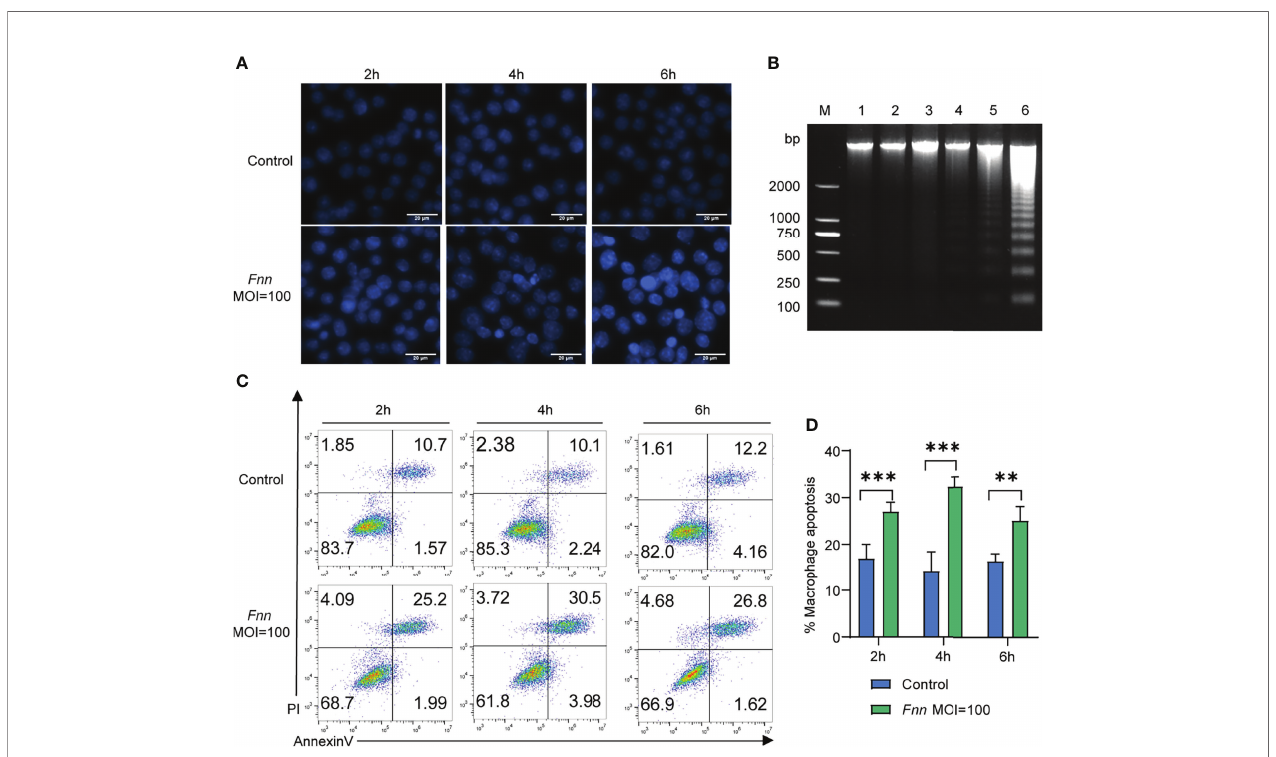
FIGURE 2 | Apoptosis of macrophages cells induced by F. necrophorum (MOI=100). (A) Hoechst 33258 staining fl uorescent display. (B) Effect of the F. necrophorum on chromosomal DNA fragmentation (Lane M: DNA marker 2000; Lane 1, 3, and 5: macrophages were cultured for 2, 4, and 6 h without F. necrophorum ; Lane 2, 4, and 6: macrophages cultured for 2, 4 and 6 h incubated with F. necrophorum ). (C) . Flow cytometry analysis of macrophages apoptosis with F. necrophorum stimulation (MOIs of 0 and 100) at 2, 4, and 6 h. (D) . Statistical analysis of macrophages apoptosis with F. necrophorum stimulation (MOIs of 0 and 100) at 2, 4, and 6 h. The histogram represents the mean ± SD (n = 3). ** P <0.01, *** P